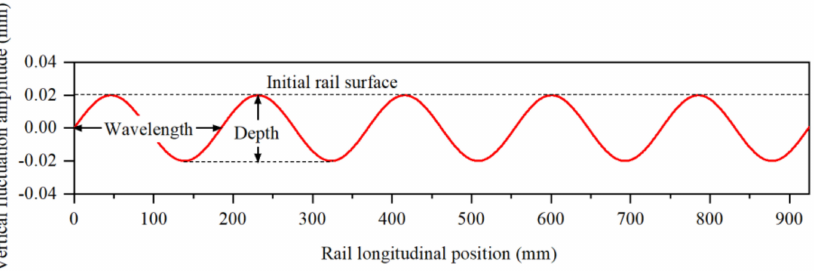
Figure 5. Design of rail corrugation with the wavelength of 140